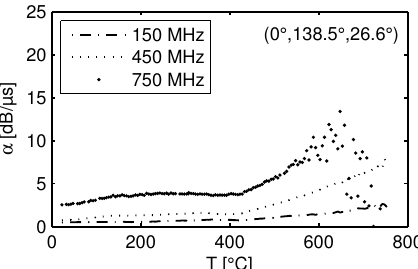
Figure 13. The propagation loss in [dB/µs] of Rayleigh waves on metallized surface on cut (0, 138.5, 26.6 ◦ ) for different frequencies.